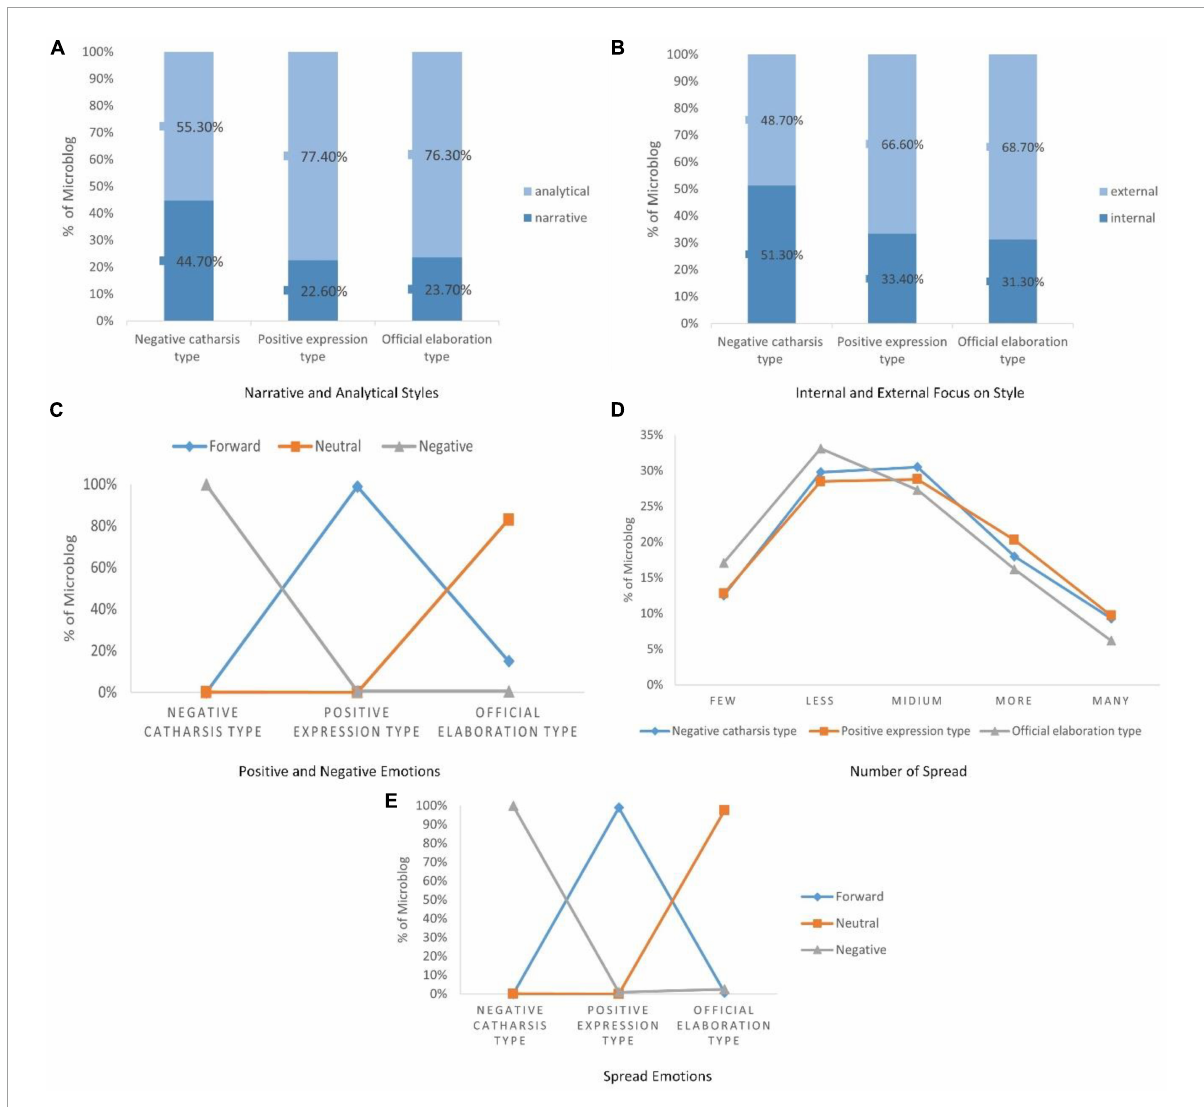
FIGURE7 Linguistic style and user communication characteristics of celebrity Microblogs in distinct